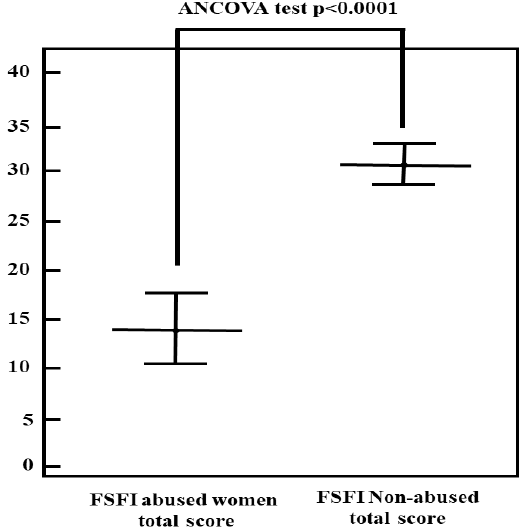
Figure 2. Graphical representation of Female Sexual Function Index (FSFI) total scores between abused and non-abused women (Means and Confidence Interval (CI) 95%).